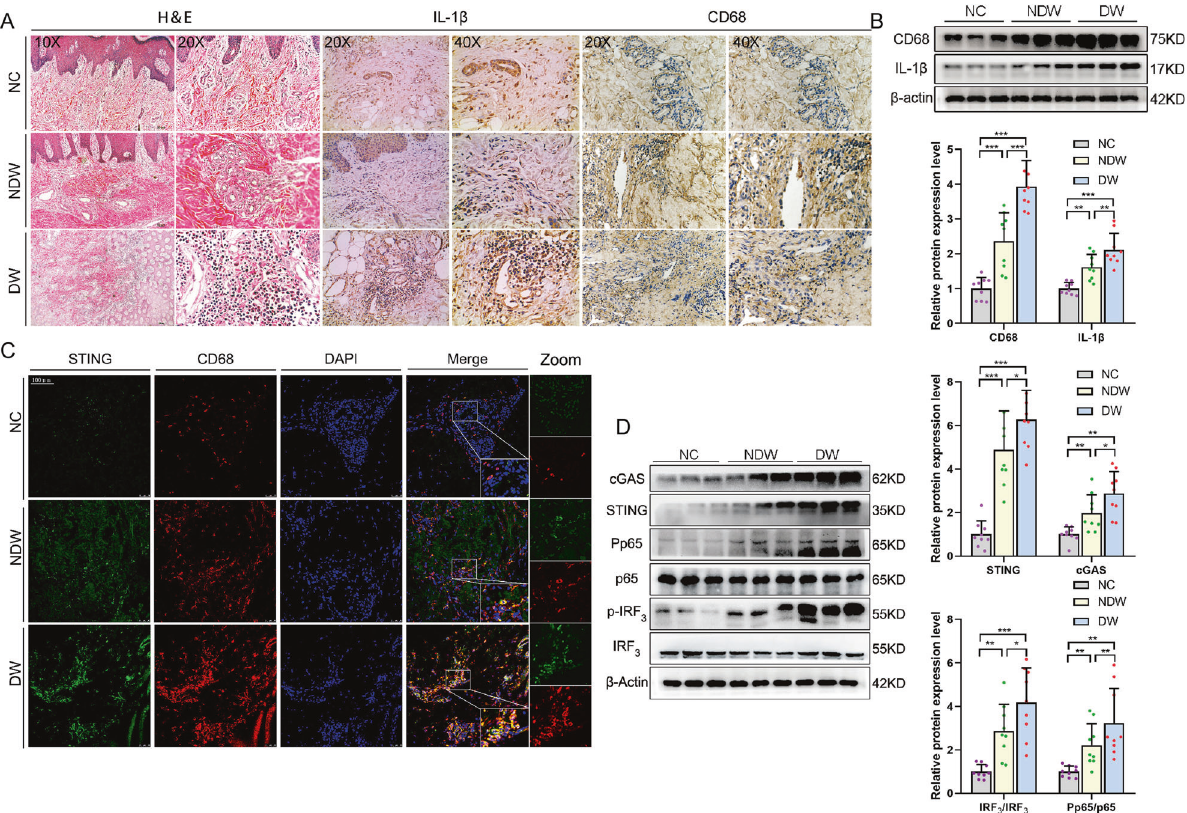
Fig. 1 STING and its downstream effectors expression are excessively increased in macrophages of human patients with DW. A Sections of NC (upper row), NDW (middle row), and DW (lower row) were stained with H&E (Columns 1 and 2 on the left) or for IL-1 β expression (Columns 3 and 4 on the left) and CD68 expression (right 2 columns). B Skin and wound lysates were examined for IL- 1 β and CD68 using western blot analysis. Blots are quanti fi ed using bar graphs. C Sections of NC (upper row), NDW (middle row), and DW (lower row) were stained with co-localization of macrophages and STING using laser confocal microscopy. Anti-CD68 antibody labeled Macrophages (red), anti- STING antibody labeled STING (green) and DAPI labeled nucleus (blue). D Skin and wound lysates were examined for cGAS, STING, and in fl ammatory signaling using western blot analysis. Blots are quanti fi ed using bar graphs. For all bar graphs, Data were represented as mean ± SD ( n = 9). * P < 0.05, ** P < 0.01, and *** P < .001, NC vs NDW, NC vs DW, NDW vs